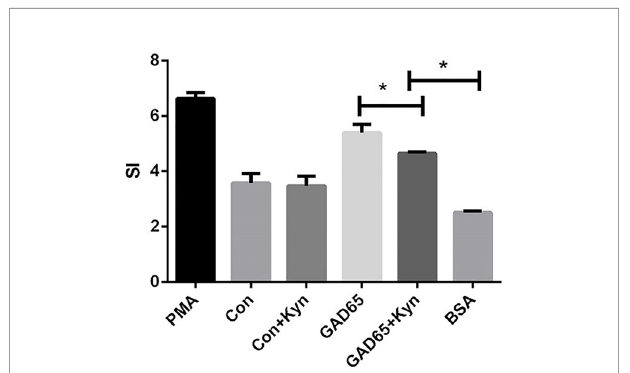
FIGURE 4 | Effects of suppressive adjuvant Kyn on the GAD65 speci fi c T cell proliferation. The proliferative response to GAD65 was signi fi cantly lower in spleen lymphocytes isolated from GAD65 phage vaccine + Kyn immunized mice than those from the GAD65 phage vaccine immunized mice (*P <